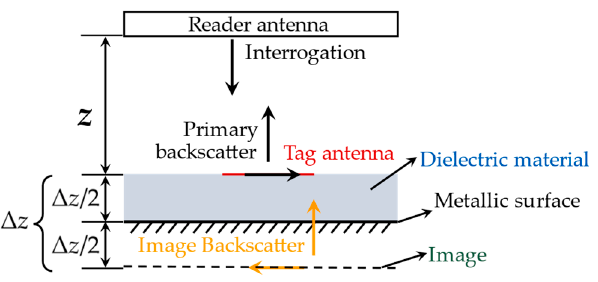
Figure 14. Effect of metallic surface on RFID tag antenna (image theory).